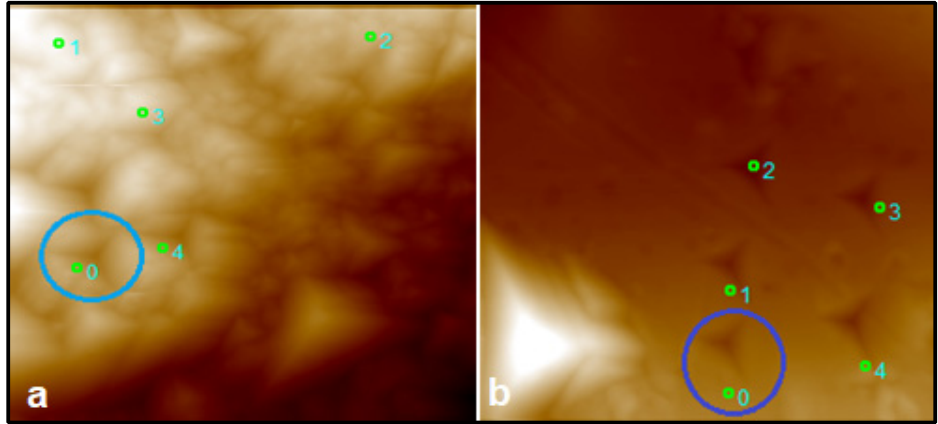
Figure 12. Micrograph of the nano-indentation on the surface of ( a ) virgin and ( b ) Ag-coated pellets.